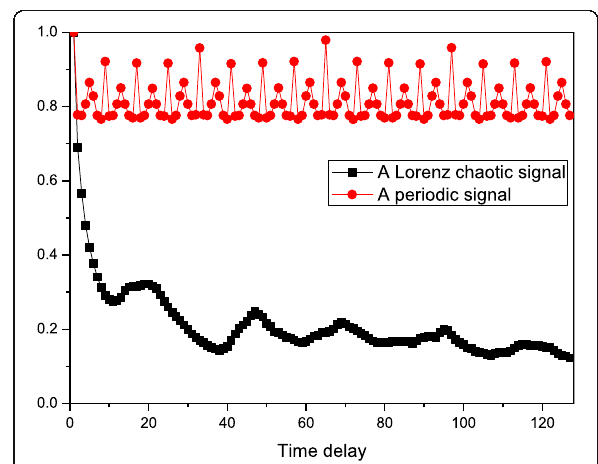
Fig. 3 Delayed mutual information sequence of two signals. This figure shows that the delayed mutual information can express the complexity of the signal. The simpler the signal is, the closer the parameter value is to 1; the more complex the signal is, and the closer the parameter value is to